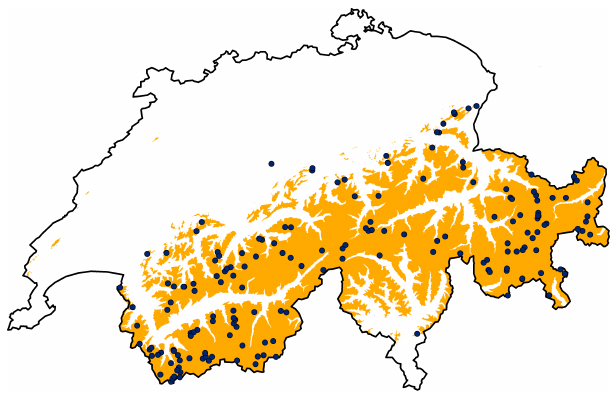
Figure 1. Map of Switzerland showing the geographical distribu- tion of fatal avalanche accidents while backcountry touring during the winter months December to April for the 20 years 1994/95– 2013/14 (blue points, data: Swiss avalanche accident database). The elevation range above 1500ma.s.l., where more than 95% of the avalanche accidents occurred, is shaded orange. Map data: dhm25 © 2015 swisstopo (5704000000), reproduced by permission of swisstopo